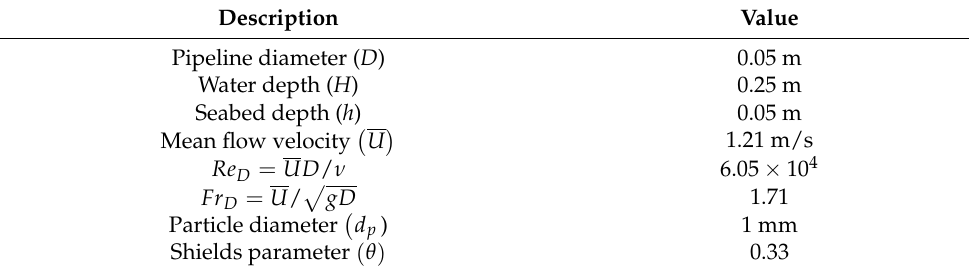
Table 1. Simulation conditions for pipeline scour.